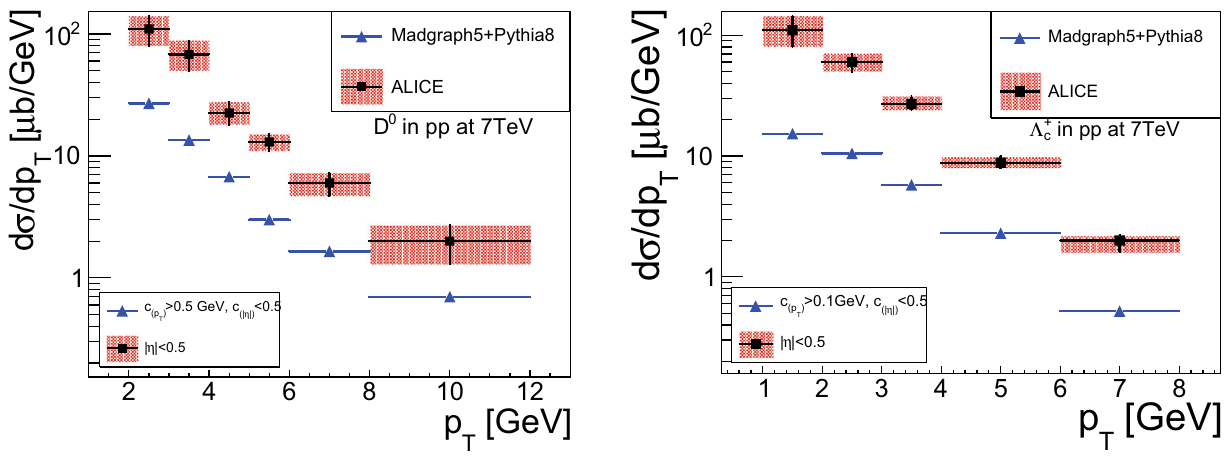
Fig. 3 MC simulation of the cross section of the inclusive D 0 (left) and (cid:5) + c (right) production in the pp collision at paring with the experimental data from Refs. [84,85]. The rapidity